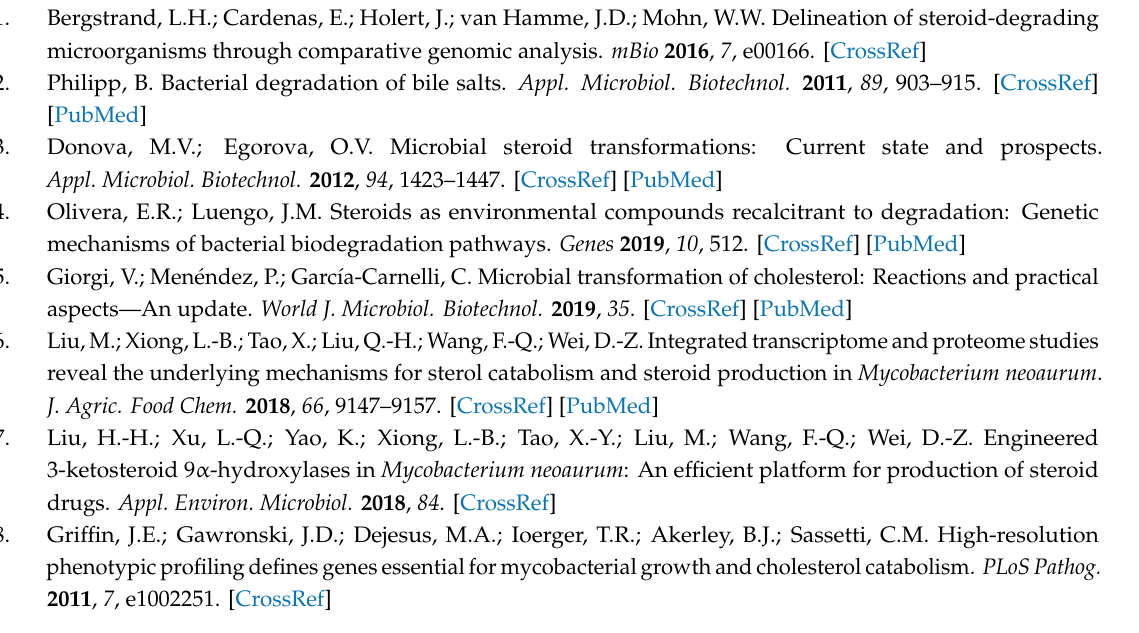
Figure S1: Change in content of the intermediates during cholesterol biotransformation by N. simplex VKM Ac-2033D. ( a ) 3-Oxo-cholest-4-en-26-oic acid and 3-oxo-cholesta-1,4-dien-26-oic acid (TLC, visualization under UV, 254 nm). The reference compound is cholest-4-en-3-one. ( b ) 3 β -Hydroxy-cholest-5-en-26-oic acid visualization after phosphomolybdic acid (TLC, visualization with phosphomolybdic acid staining). The reference compound is cholesterol. C . LCA decrease during its bioconversion by N. simplex (visualization with MnCl 2 staining). The reference compound is 3-oxo-deoxycholic acid. Figure S2: LOGO of transcriptional regulator motifs. ( a ) Motif for Lcin1. ( b ) Motif for Lcin2. Table S1: Real-time PCR. Table S2: List of orthogroups. Table S3: Steroid intermediates and full characteristics. Table S4: Read counts. Table S5: DEGs, operons, and predicted regulons. Author Contributions: V.Y.S. designed research, made sequencing libraries, and analyzed data. M.I.S.